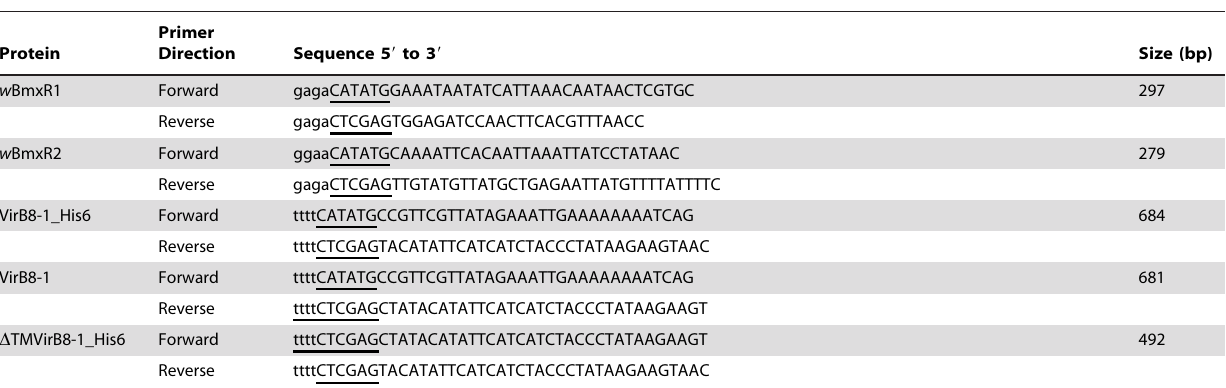
Table 2. Primers used to construct expression plasmids.